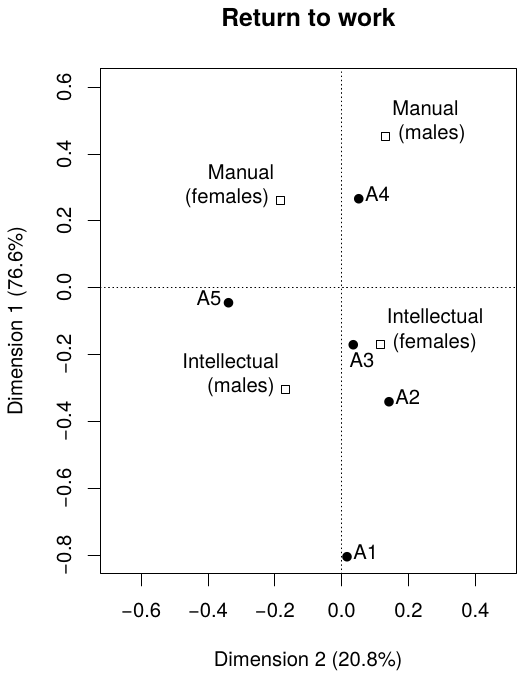
Figure 4. Classification map (question No.